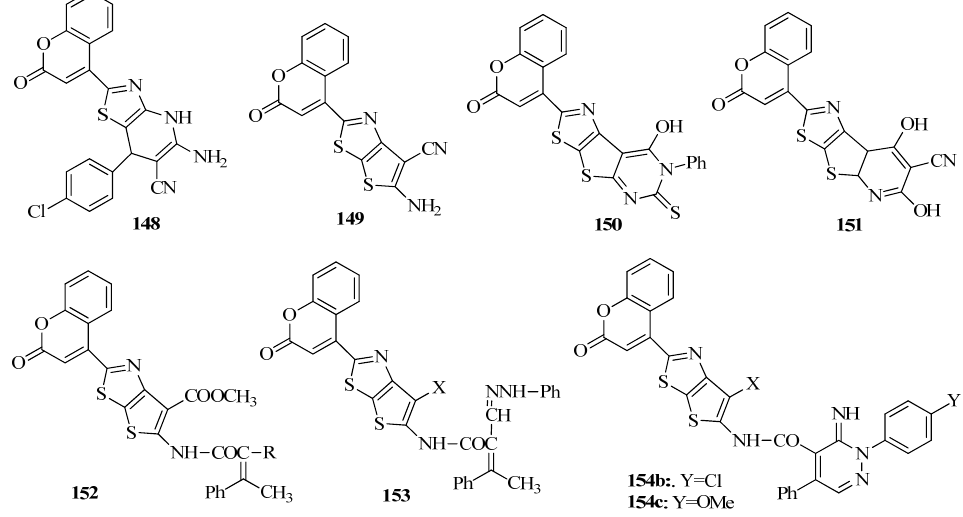
Figure 59. Structure of fused thiazole derivatives from 2-(2-oxo-2 H -chromen-3-yl)thiazol-4(5 H )-